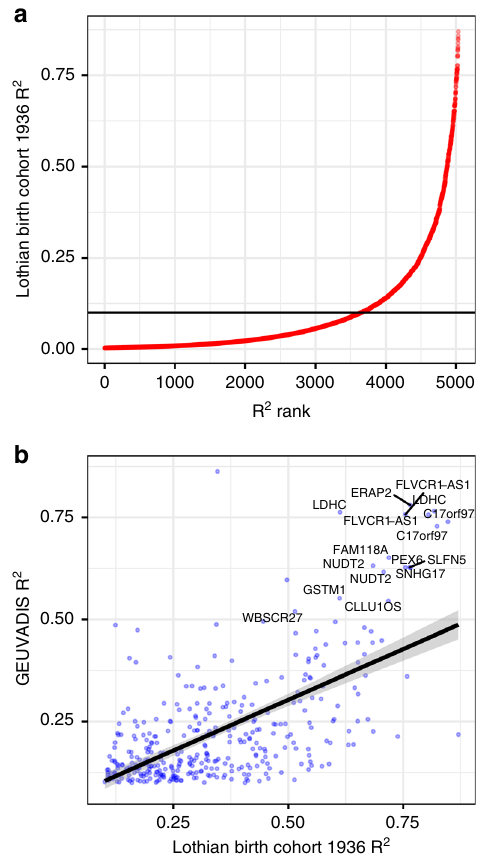
Fig. 2 Model prediction performance and validation. a R 2 of predicted versus observed gene expression levels in the Lothian Birth Cohort (LBC1936) against the rank of the R 2 value. Only the 5033 genes that passed the kurtosis threshold are shown. The horizontal line indicates an R 2 = 0.1, for which the 1205 genes exceeding this threshold were retained for further analysis. b Validation of the LBC1936 gene prediction models using the 1000 Genomes data. Genes with an R 2 > 0.1 across both datasets are plotted, with genes with an R 2 > 0.5 in both datasets labelled. Genes annotated twice have more than one probe on the array used in the LBC1936